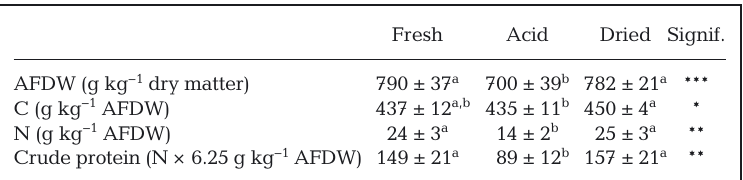
Table 2. Composition of experimental diets fed to polychaetes in the weeks prior to respiration and excretion measurements, i.e. fresh salmon faeces